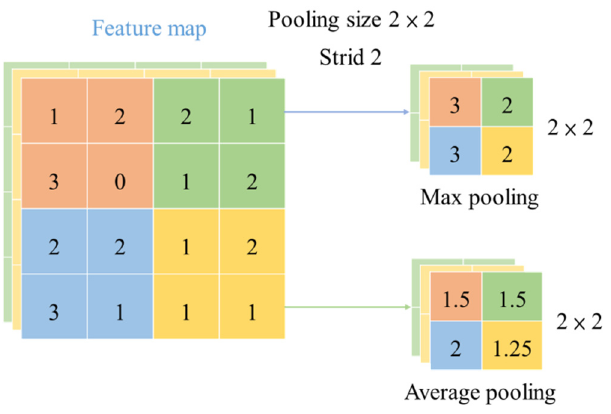
Figure 14. The operation mode of the pooling layer.